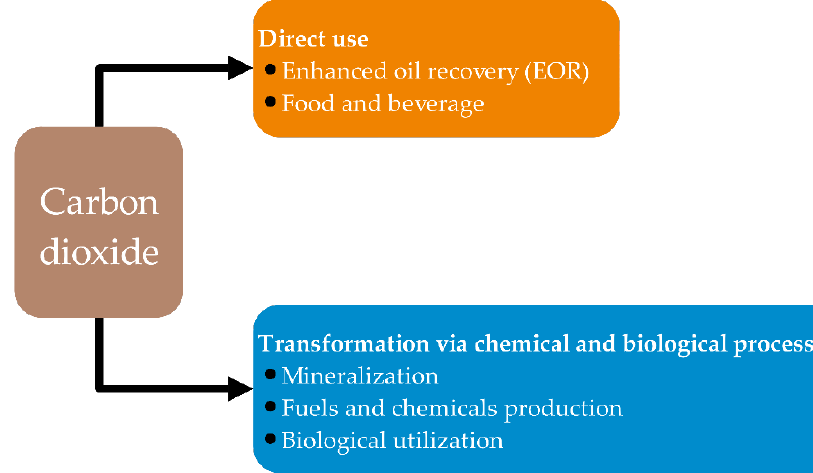
Figure 1. The approaches to utilize carbon dioxide.